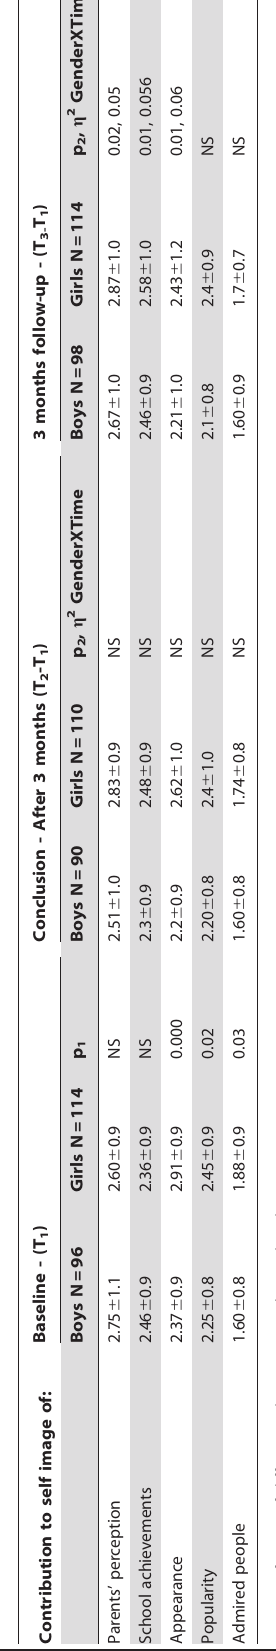
Body image. Body image was measured using The Figure Body Images (FBG) [25]. Participants were asked to score silhouettes in respect to each of the 6 variables: current body image, ideal body image, attractive body image of both genders and healthy figures of both genders. Mean ratings and standard deviations of participants’ body figures according to gender are presented in table 3. size of gender on body image perceptions (F(6,205)= 4.69, p = 0.000, partial g 2 = 0.25). between genders in perceptions of ideal self-figure, attractive figures and healthy figures (Table 3). Boys perceived their current body figure almost the same as their ideal, attractive and healthy figures while girls perceived their current body figure as substantially higher than their ideal, attractive and healthy figures. The relative placement of the current body figure of girls (top) and boys (bottom), in respect to the ideal, attractive and healthy figures is presented in Figure 3. Time had significant effect only on perception of ideal body figure (Table 3) [Univariate: F(2,205)= 3.36, p = 0.03; Partial g 2 = 0.037). At baseline, the mean ideal body figure of girls in the intervention group was 2.93 6 0.8, at program conclusion it increased to 2.98 6 0.7 and at the 3 month follow-up it further increased to 3.11 6 0.7. The difference between T 3 and T 1 in respect to perceived ideal body figure was statistically significant (Univariate: F(2,205)= 4.95, p =0.029; Partial g 2 = 0.054). In respect to the gap between current figure and the ideal, attractive and healthy figures, there was a consistent difference between the genders. Girls always perceived their current body figure above their ideal figure as well as above girls’ attractive and even healthy figures, while boys always felt their current body figure is below their ideal as well as below boy’s attractive and healthy figures (Figure 3). This trend was observed during all three assessment points. The impact of the intervention was different among genders, but it did not reach a statistically significant effect. assessments, increase in the gap between current figures vs. ideal or attractive figures, in girls the gap decreased. current figure and healthy figure decreased. In girls it even reached 0 at program termination. Eating disorders features. At baseline, MANOVA revealed significant impact of gender on body dissatisfaction and drive for thinness [F(2,204) = 6.9, p= 0.001, partial g 2 = 0.066). Girls reported on statistically significant higher scores than boys in both EDI-2 scales: body dissatisfaction [F(1,204) = 14.5 p= 0.002, partial g 2 = 0.047) drive for thinness scale [F(1,204) =22.9, p = 0.000, partial g 2 =